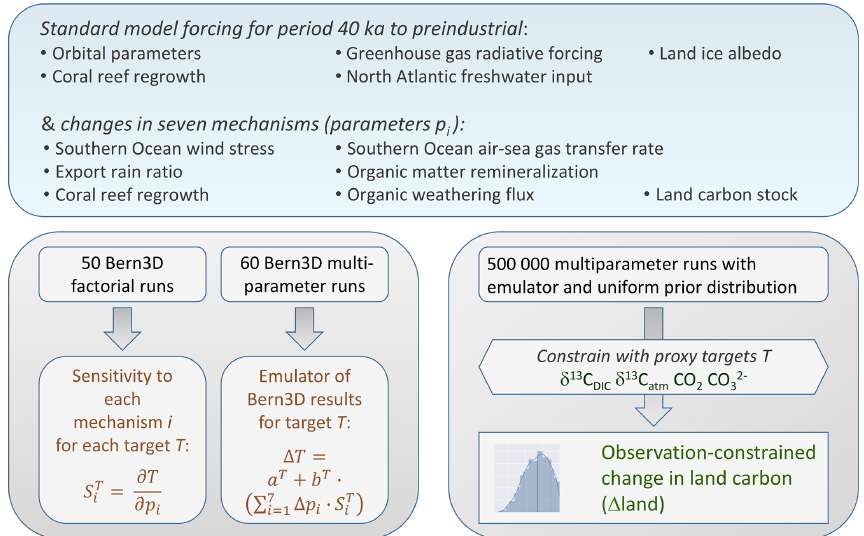
Figure 1. Flow chart outlining the steps applied to achieve an estimate of possible (cid:49) land values. To this end, seven generic deglacial carbon cycle mechanisms (Table 2 and Sect. 2.2) and four observational targets (Sect. 2.2.3) were included. The seven processes are varied individually by systematic parameter variations in addition to the well-established forcings (top of figure) in 50 factorial simulations with the Bern3D. This yields a first set of sensitivities or forcing–response curves for our four targets and seven processes. Next, we apply a Latin hypercube parameter sampling to vary the processes in combination and probe for nonlinear interactions in 60 multiparameter simulations with the Bern3D model. The results are used to adjust the forcing–response relationship; adjustments are small, except for CO 2 response curves (see Fig. C1 in the Appendix). Analytical representations of the forcing–response curves are used to build a simple emulator of the Bern3D model (Sect. 2.2.4). The emulator is applied in a Monte Carlo ensemble with half a million members to probe a wide range for each individual process. Finally, the ensemble results are constrained by the four proxy targets to yield a best estimate and an uncertainty distribution for (cid:49) land.